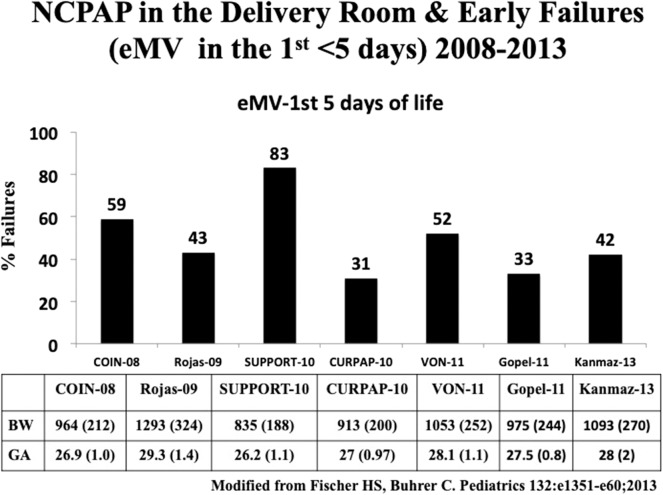
Advantages of RAM NC over Bag & Mask in the delivery room.